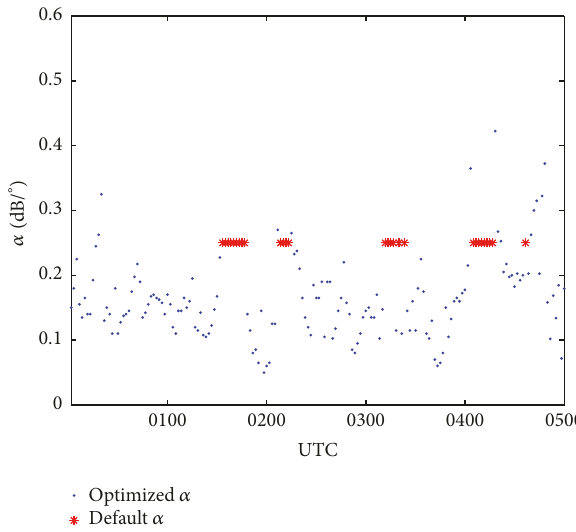
Figure15:Distributionoftheoptimized 𝛼